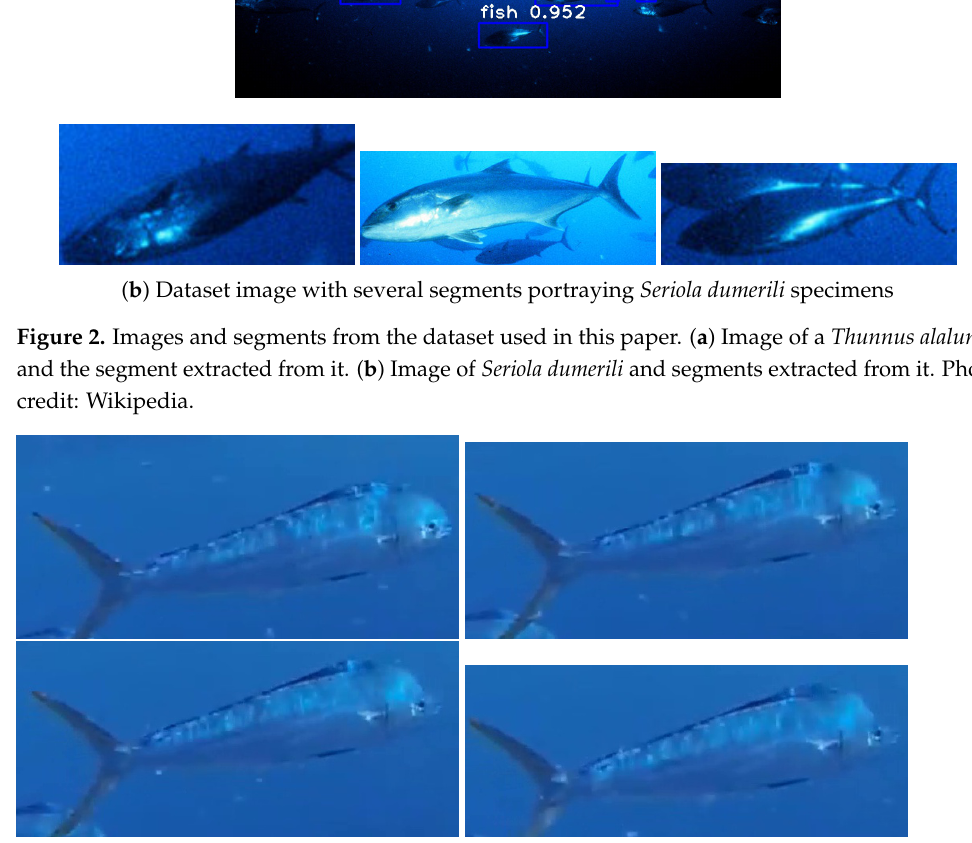
Figure 3. Segments from a Coryphaena hippurus extracted from consecutive frames of a